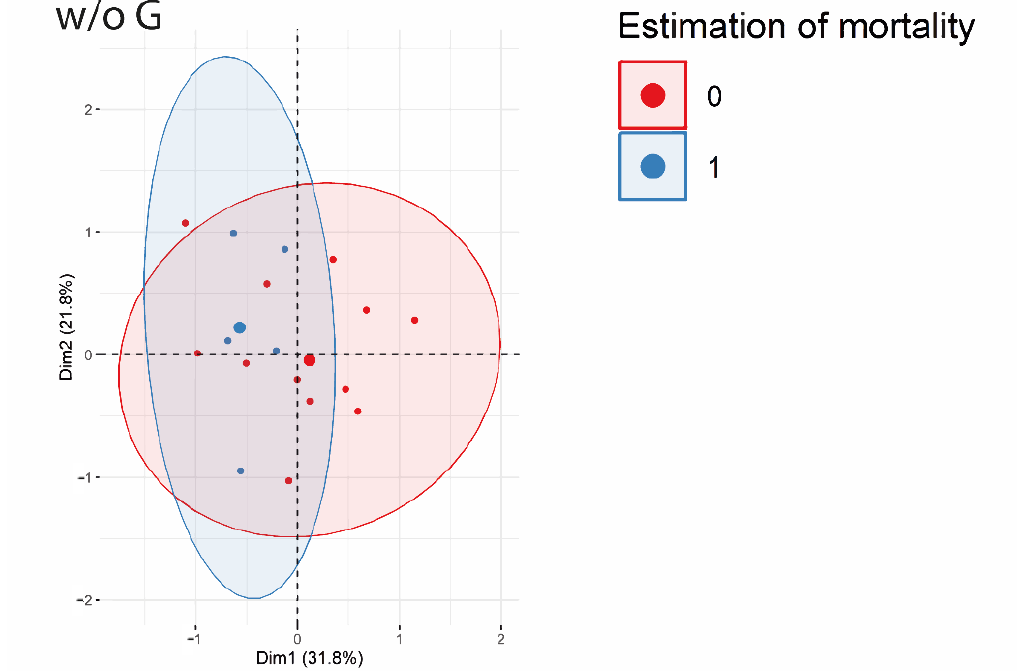
Figure A7. Graphic representation of estimation of mortality calculated (1) or not (0) for all five MCAs. Table A1. Country acronyms used in Figures 7 and